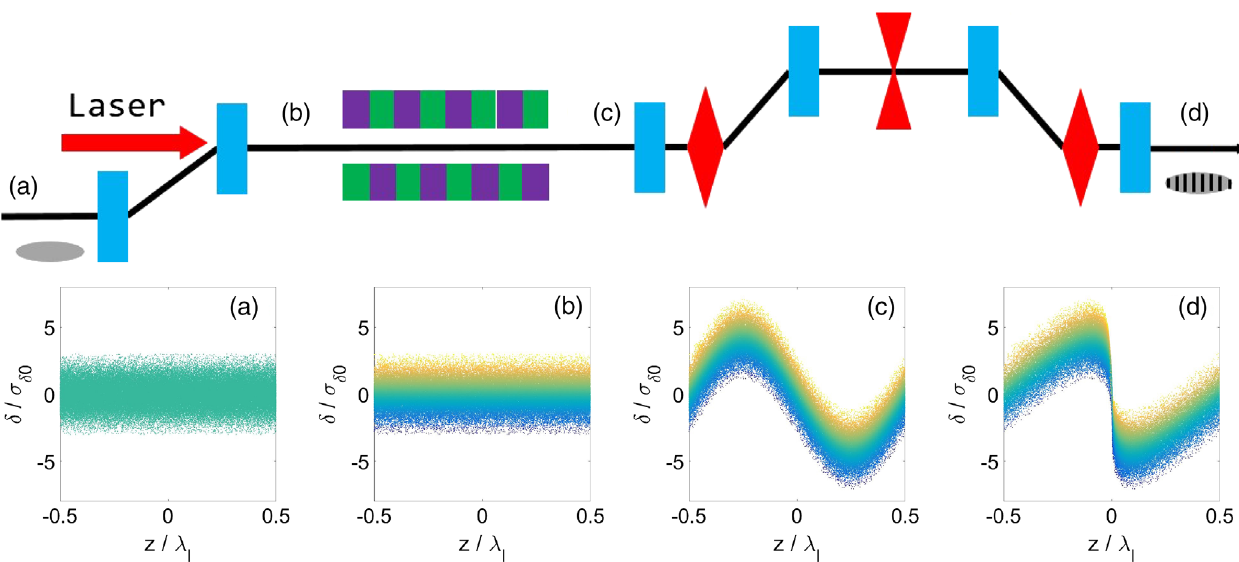
FIG. 7. Schematic layout (top) and longitudinal phase-space evolution (bottom) of the proposed PEHG variant. (a) before entering the PEHG unit, (b) after the dispersion-generation device, (c) after the energy modulation, (d) after the dispersive section with phase- merging function to form microbunching. Different colors in the phase-space plots represent different horizontal positions. Compared to the original PEHG scheme, the phase-merging function is shifted downstream to the dispersive section by introducing a transverse gradient in the bending dipoles or inserting quadrupoles in